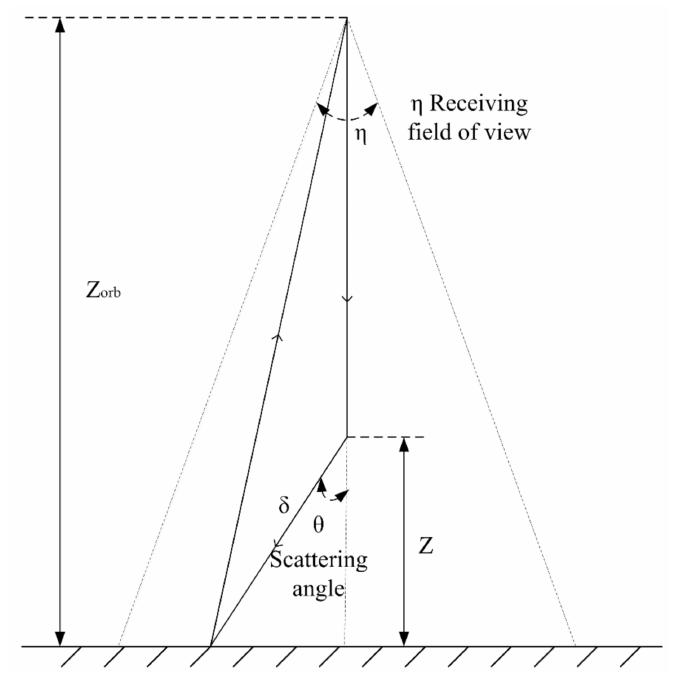
Figure 2. Schematic diagram of atmospheric single-scattering delay